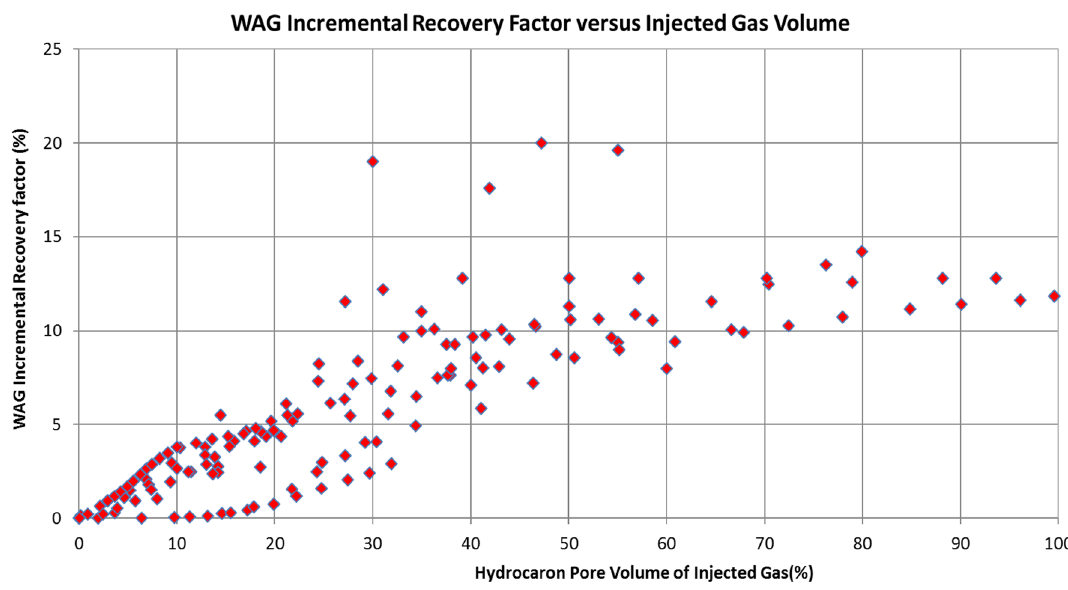
Fig. 2 Summary of WAG incremental recovery factor from WAG